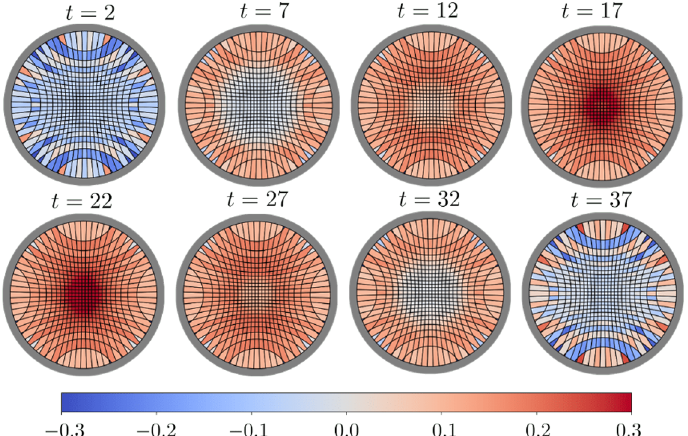
Figure 10. Quenched time dynamics of the reconstructed geometry corresponding to a global mass deformation (see figure 9 for the t = 0 geometries). The component h 22 is shown here. The boundary relative error is maximal E bdy ≈ 0 . 22 near t = 0 and is minimal E bdy ≈ 0 . 006 around t = 20